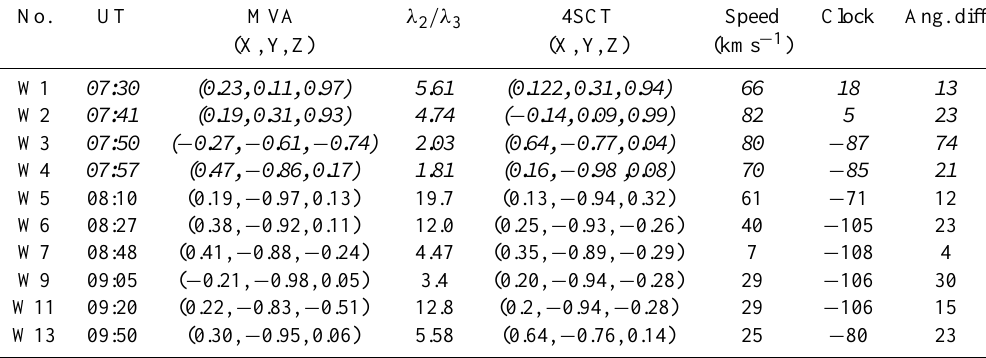
Table 2. The outputs of the minimum variance analysis (MVA) and four spacecraft timing analysis (4SCT) of the magnetic field data from Cluster. The MVA vectors and eigenvalue ratios ( λ 2 /λ 3 ) have been averaged across the four spacecraft. The clock angle (angle between the Z and Y components) of the 4SCT vector is given, along the the angular difference between the vectors from the two techniques.